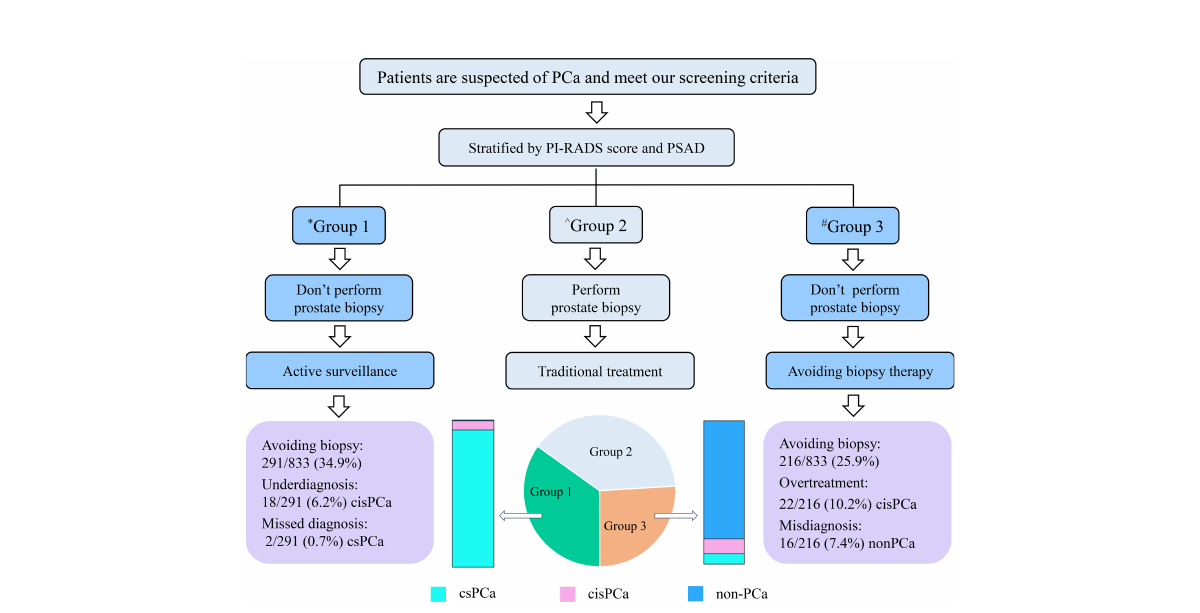
FIGURE 4 Flowchart of the strategy for avoiding unnecessary prostate biopsy. *Group 1 patients with PI-RADS score < 3 and PSAD < 0.3; ^ Group 2 patients with “ PI-RADS score ≥ 3 and PSAD < 0.3 ” or “ PI-RADS score < 3 and PSAD ≥ 0.3 ” ; # Group 3 patients with PI-RADS score > 3 and PSAD ≥ 0.3.